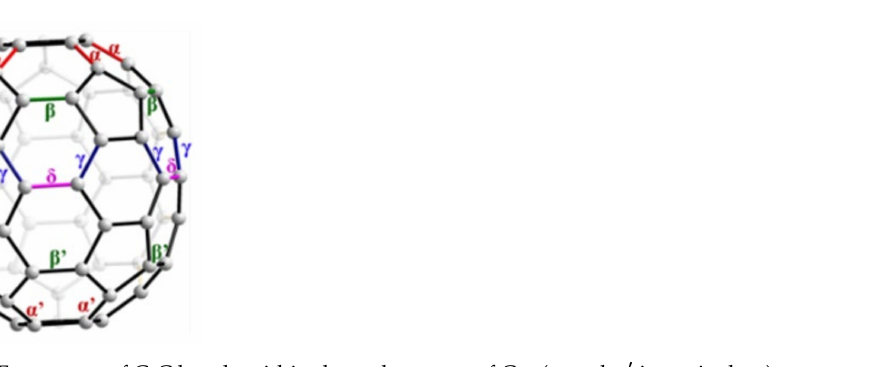
Figure 1. Four types of C-C bonds within the carbon cage of C 70 ( α and α (cid:48) is